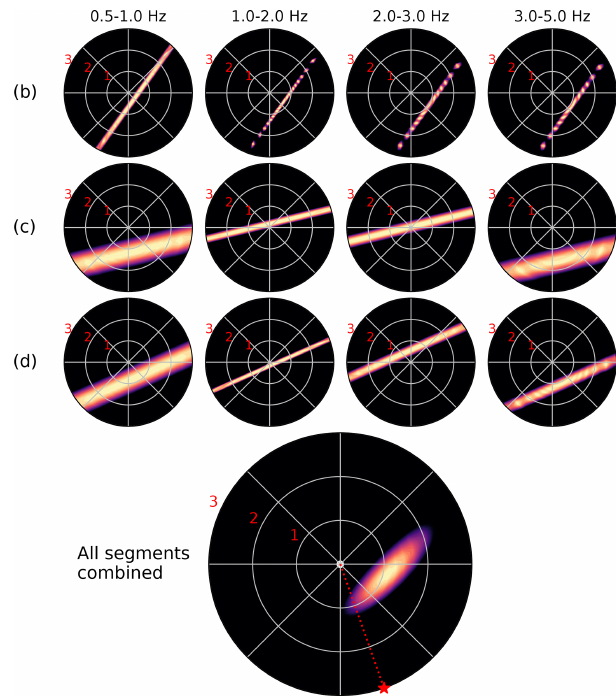
Figure 11. Beamforming results of the P waveforms recorded on selected segments of the DAS array. In this figure, the panels show pseudo-power ˆ P normalised by the maximum power, such that 0 ≤ ˆ P ≤ 1, plotted as a function of the back-azimuth and apparent slowness of the candidate source. The slowness values (in skm − 1 ) of the radial grid lines are as indicated by the red numbers. The let- ters indicated on the left of each row correspond to the panels in Fig.